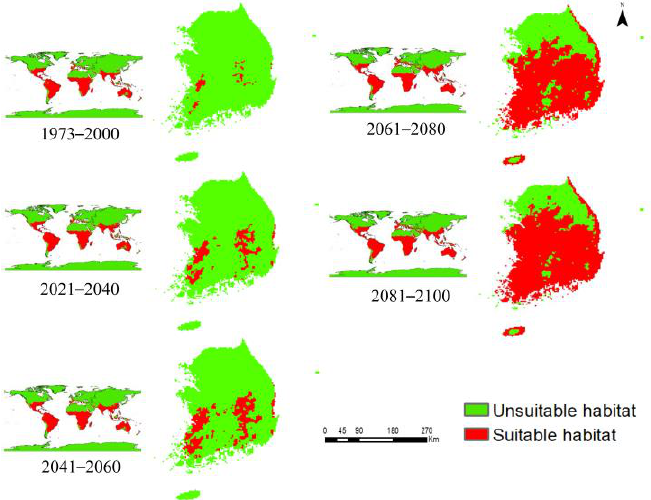
Figure 2. Potential distribution of P. hysterophorus around the world and in South Korea under the current climate (1973 – 2000) and future climate scenario (SSP2-4.5; 2021 – 2040, 2041 – 2060, 2061 – 2080, and 2081 – 2100). Green and red colors indicate the unsuitable and suitable habitats for P. hysteroph- orus , respectively.